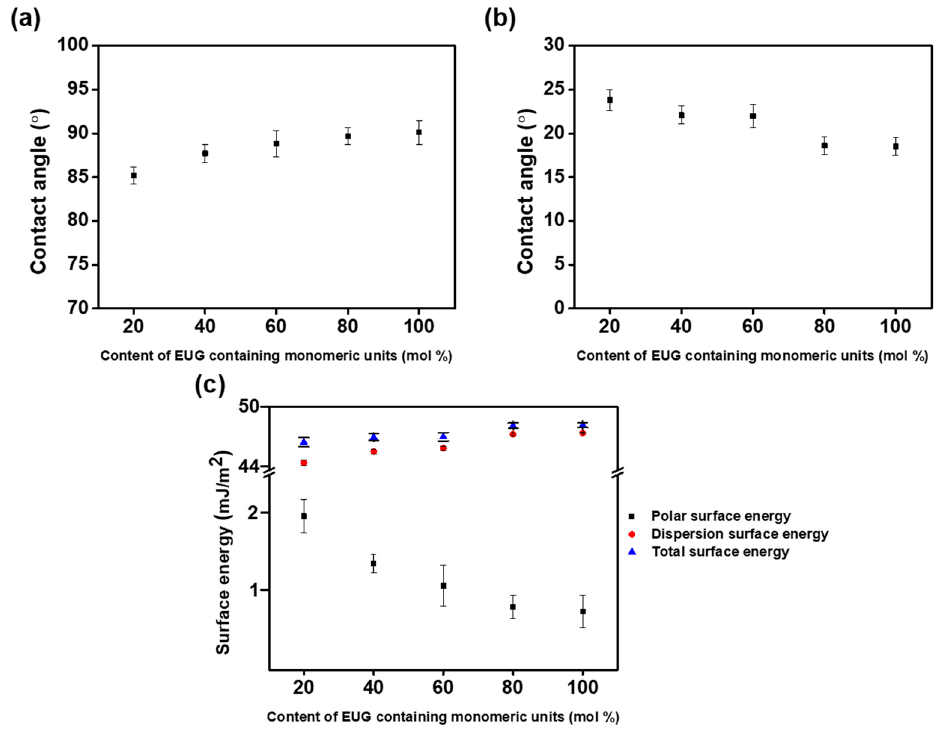
Figure 6. ( a ) Water, ( b ) diiodomethane contact angle, and ( c ) surface energy values of PEUG# films according to the molar content of the eugenol moiety in the side groups.